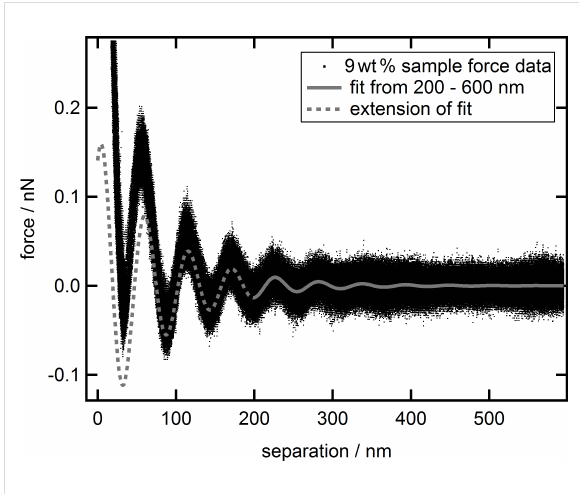
Figure 4: Combined force data of the 9 wt % suspension (black dots) together with fit based on Equation 1 made from 200 to 600 nm (solid grey line) and extension of that fit towards smaller separations (dashed gray